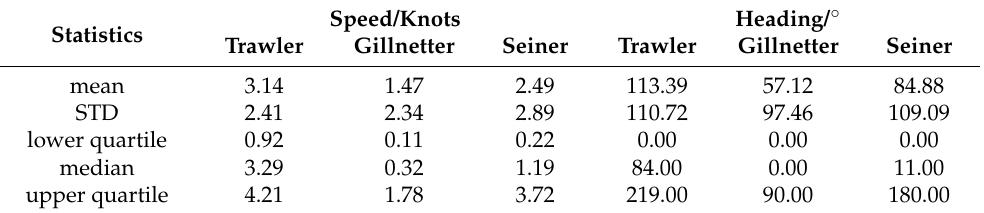
Figure 5. Box diagrams of speed ( a ) and heading ( b ) for trawlers, gillnetters and seiners. Table 2. Statistical values corresponding to the box diagrams of the speed and heading for trawlers, gillnetters and